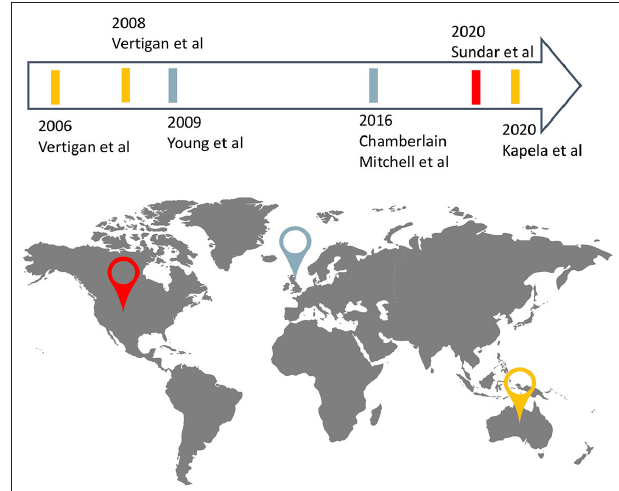
FIGURE 2 | Countries of origin and date of publication of records included in the review.